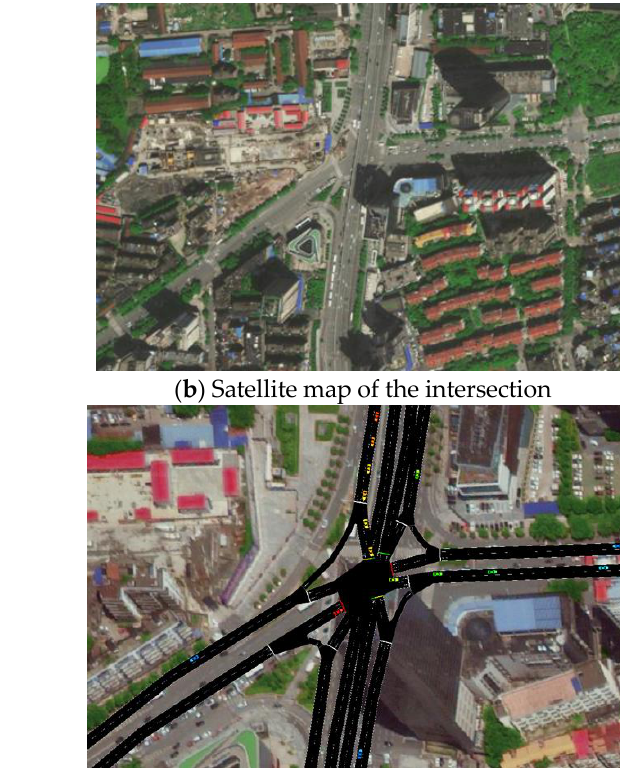
Table 1. Information for generating traffic demand in ActivityGen.